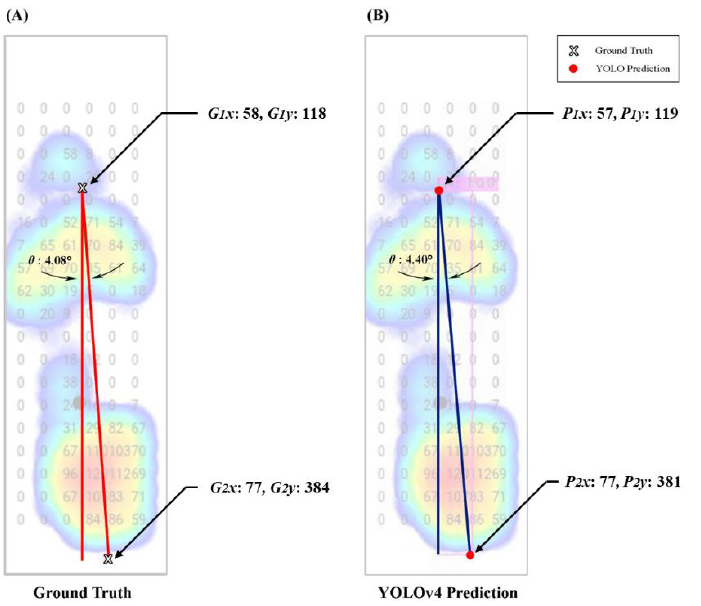
Figure 9. Examples of validation using photoshop software for the left foot profile. ( A ) the ground- truth angle of 4.08 ◦ was compared with ( B ) the same images from the YOLOv4 prediction with an angle of 4.40 ◦ . Note: G 1 x and G 1 y are front foot axis points of the ground-truth. G 2 x and G 2 y are rear foot axis points of the ground-truth. P 1 x and P 1 y are the front foot axis point of the YOLO model. P 2 x and P 2 y are the rear foot axis point of the YOLO model.